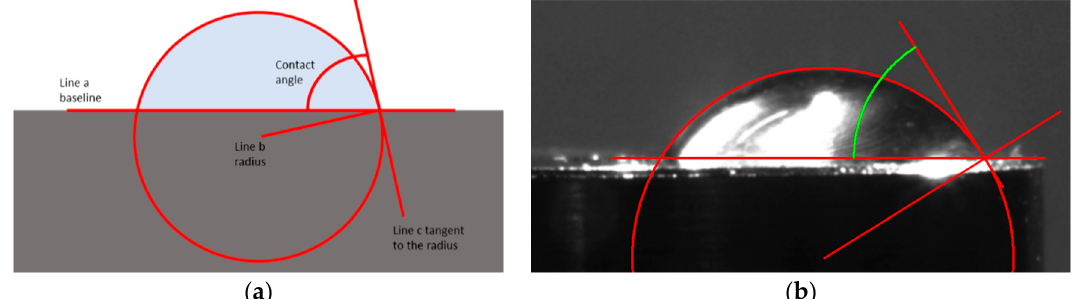
Figure 1. ( a ) Geometric construction for the determination of the contact angle. These reference points are straight line a , passing across the two points of contact between implant surface and the blood drop, straight line b , which is the radius of the circumference created by the blood drop (constructed with best fit), prolonged to intersect one of the point of inter- section between the circumference and the line a , and the line c , perpendicular to line b and tangential to the circumference at the point of intersection with line a . With these reference points, it is possible to calculate the angle between line c and line a , which corresponds to the contact angle between the blood drop and the surface. The smaller is the angle, the greater is the adhesion of the drop, and therefore the greater is the wettability. ( b ) Picture was taken with Leica FDC 320® camera (Leica ® , Wetzlar, Germany) set on an optical microscope Leica MZ16® (Leica ® , Wetzlar, Germany). Reference points in the picture were marked with Image ProPlus ® software (Media Cybernetics ® , Rockville, MD, USA).